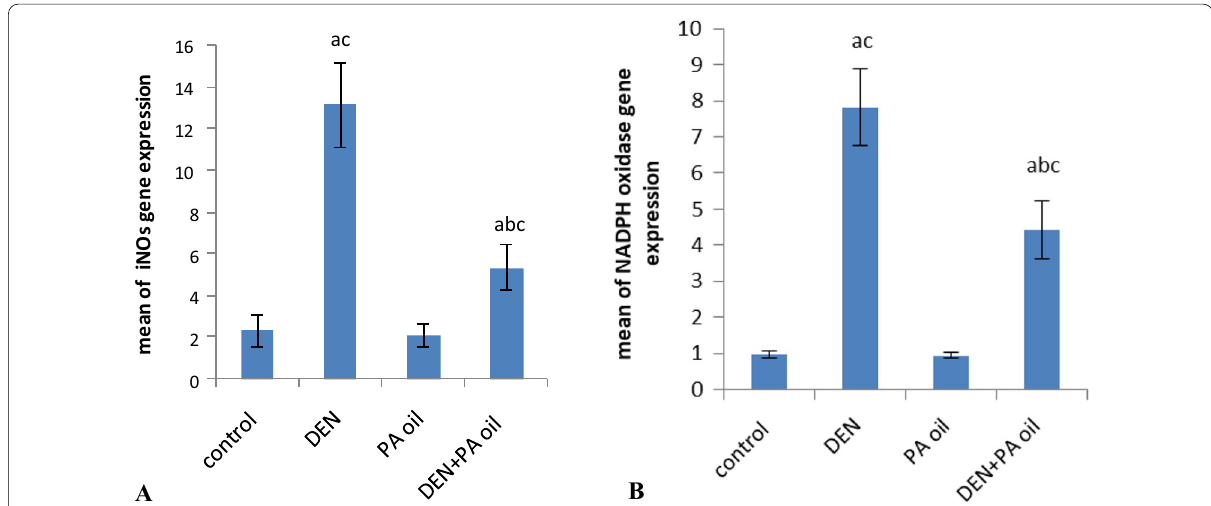
Fig. 3 a Effect of PA oil on liver tissue iNOS gene expression activities in rats subjected to induced hepatotoxicity. The values are expressed as mean SD ( n 6). a Significant to normal control group ( P ± = = b Effect of PA oil on liver tissue NADPH oxidase gene expression activities in rats subjected to induced hepatotoxicity. The values are expressed as mean SD (n 6). a Significant to normal control group ( P ± = =